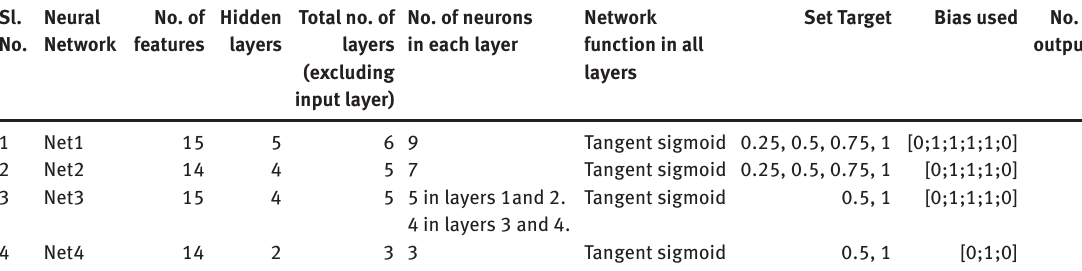
Table 2: Network Parameters used in the Developed Neural Network Design.